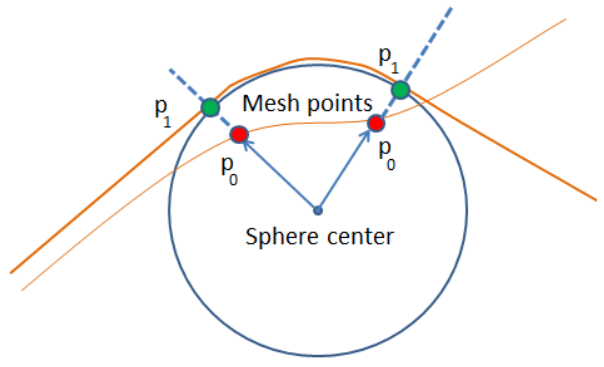
Fig. 2. Naive method, example of mesh particles offset towards the surface - from p 0 to p 1 .